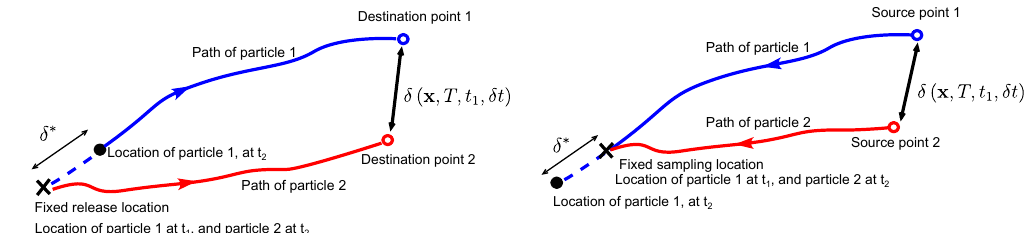
Figure 2. Two sequentially released (left panel)/collected (right panel) particles at a fixed location shown by a bold cross. Particles 1 and 2 are released/collected at t 1 and t 2 = t 1 + δt , respectively (the time interval between the two sequential samplings is δt ). The integration time between the destination/sources and the release/sampling location is approximately T for both particles ( | T |(cid:29) δt ). The displacement of the first particle during δt is shown by δ ∗